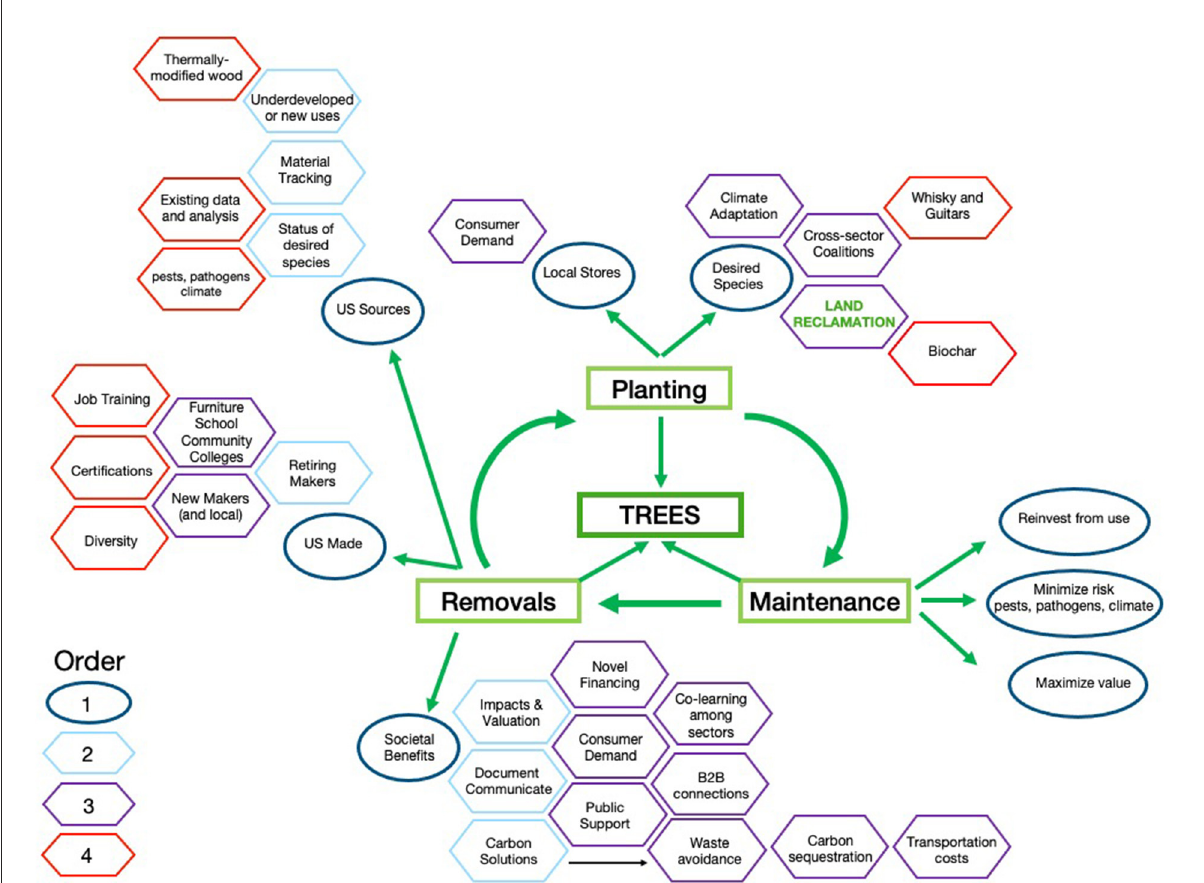
FIGURE6 Room and Board and its potential role in circular economies. Understanding the perspectives and motivations of specific actors in the urban wood systems (re. Figure 4) can be used to analyze how they can engage with the virtuous cycle of tree planting, maintenance, and removals.